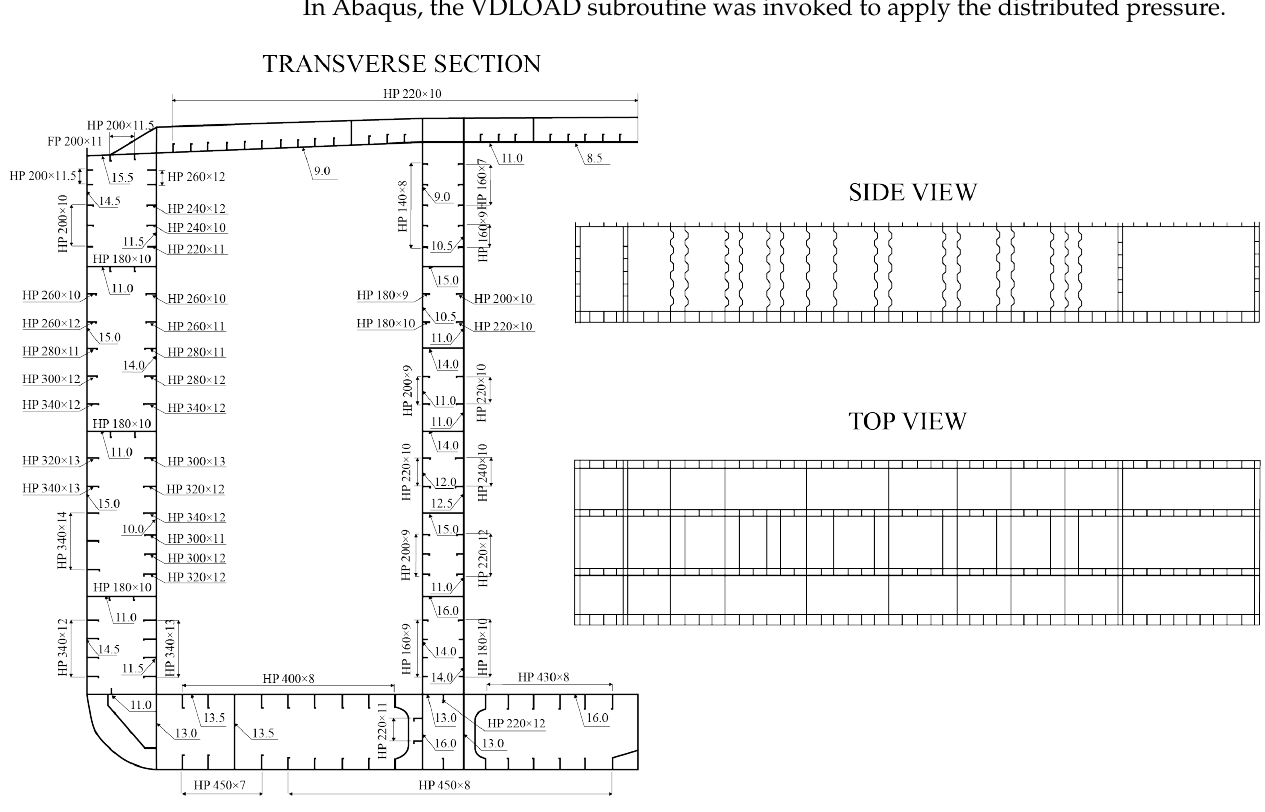
Figure 7. Design of hull structure for case study: midship section ( left ) and side view and top view ( right